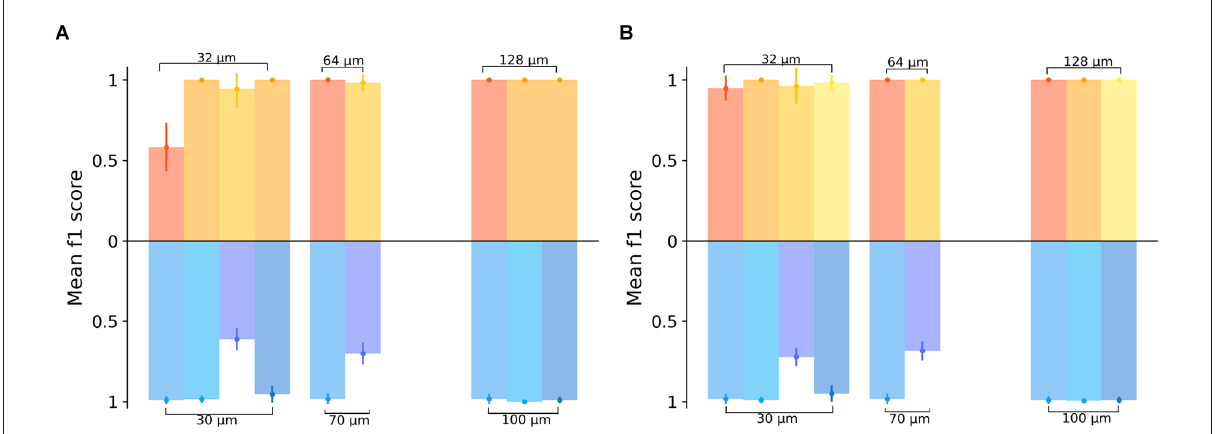
FIGURE5 Comparing the spatial resolution of electrically or optogenetically stimulated RGCs in the same retinal sample. (A) Classification results of the grating pattern reversal stimuli inferred from a subset of RGCs responding to both stimulation types, electrical (yellow) and optogenetic (blue). In the upper part of the graph, the yellow color-coded bars show the results obtained from four different electrically stimulated retinae. The blue scheme shows the results for the same responsive RGCs in the same four retinae upon optogenetic stimulation. Each bar for the electrical stimulation corresponds to a bar on the optogenetic stimulation at the same x-position on the graph, indicating that the same experimental day and the same sample was used in the analysis. We note that for gratings wider 32 µ m not all protocols were applied or activated sufficient RGCs. (B) Classification results for the full datasets in the four retinae stimulated by electrical and optogenetic means, i.e., with RGCs responding to either electrical or optogenetic stimulation. In the upper part of the graph, the yellow color-coded bars show the results from the RGC datasets upon electrical stimulation, while in the lower part the prediction results inferred from the optogenetic stimulation are shown. Each bar for the electrical stimulation corresponds to a bar on the optogenetic stimulation at the same x-position on the graph, indicating that the same sample was considered in both